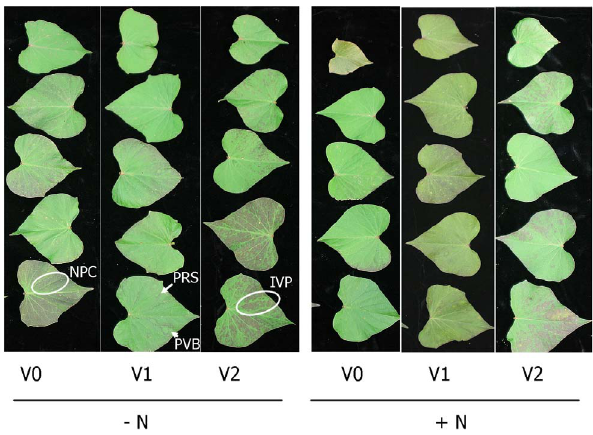
Figure 1. Virus symptoms on ‘Beauregard’ sweetpotato leaves the day before the first experiment was terminated. All expanded leaves originating from nodes above the substrate surface are depicted with the bottom leaf in each column being the oldest and the top being the youngest. + N = nitrogen provided as KNO 3 , - N=no nitrogen provided. V0 = plants derived from non-inoculated, virus- tested plant stock; V1 = plants derived from V0 plant stock graft inoculated with the potyvirus complex (SPFMV, SPVG, SPVC, and SPV2); V2 = plants derived from plant stock infected with SPCSV. Potyvirus symptoms consist of purple ring spots (PRS, see arrow) and purple vein banding (PVB arrow). Sweet potato chlorotic stunt virus symptoms include deep interveinal purpling (IVP circle) that is distinguished from the natural purple cast (NPC circle) that develops on some sweetpotato leaves in that with IVP veins remain green, and the pigmentation is deeper.